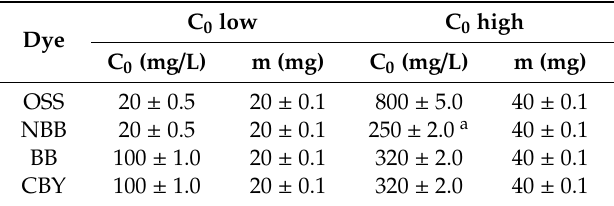
Table 1. Values of initial concentrations (C 0 ) and sponge quantities (m) for kinetic tests, where the solution volume was 25 mL. The same C 0 values are also used for comparison tests between cellulose nanosponges (CNS) and activated carbon (Section 2.7).